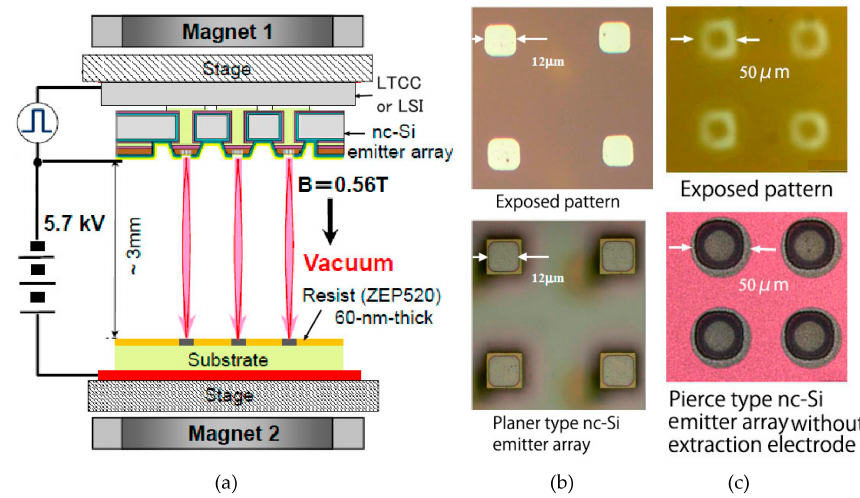
Figure 19. 1:1 electron beam exposure; ( a ) exposure system; ( b ) planer type; and ( c ) Pierce type.